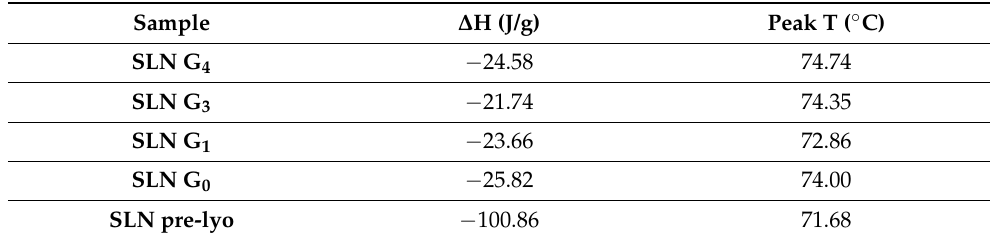
Table 5. Enthalpy variations ( ∆ H) and peak temperatures of rapidly resuspended SLNs and pre- lyophilization SLN.